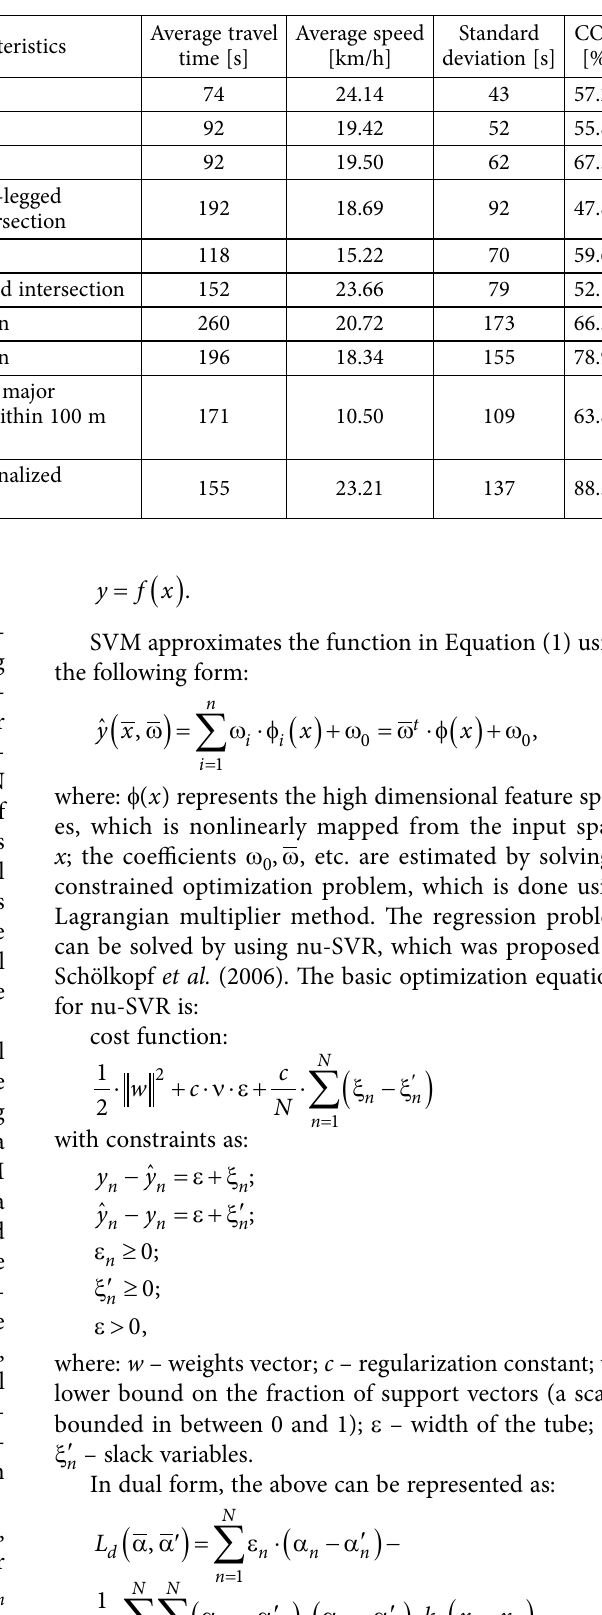
Table 2. Descriptive statistics of high mean and variance